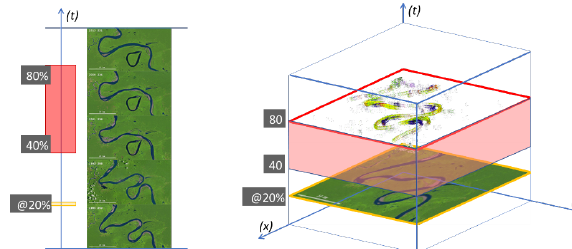
Figure 9. Representation of the rendering model with derivatives: (left) stack of images, the selected range is in red and the reference layer in yellow; (right) illustration of a potential view.